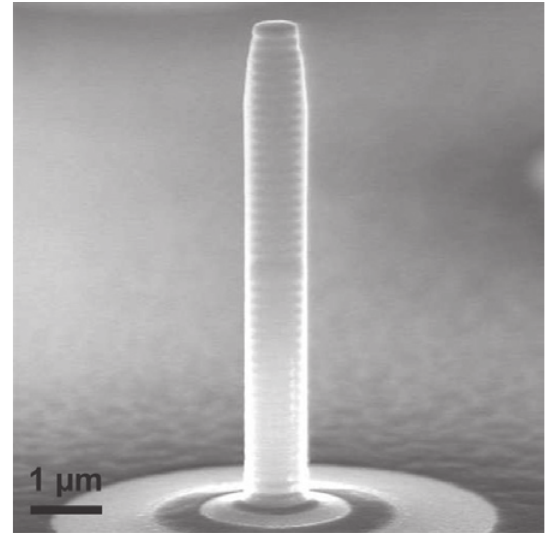
Figure 12: Scanning electron micrograph of a pillar with a diameter of about 0.8